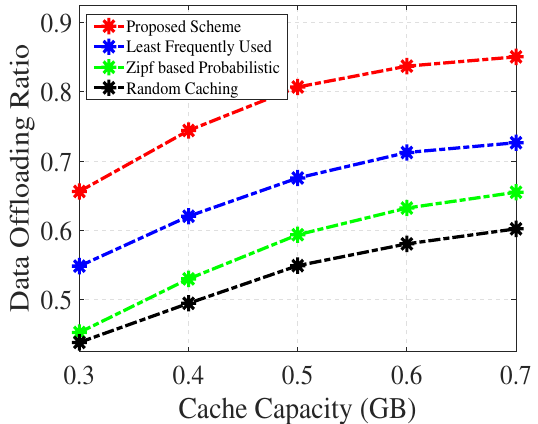
Figure 3. Data offloading ratio versus cache capacity with F = 100, H = 50 MB.